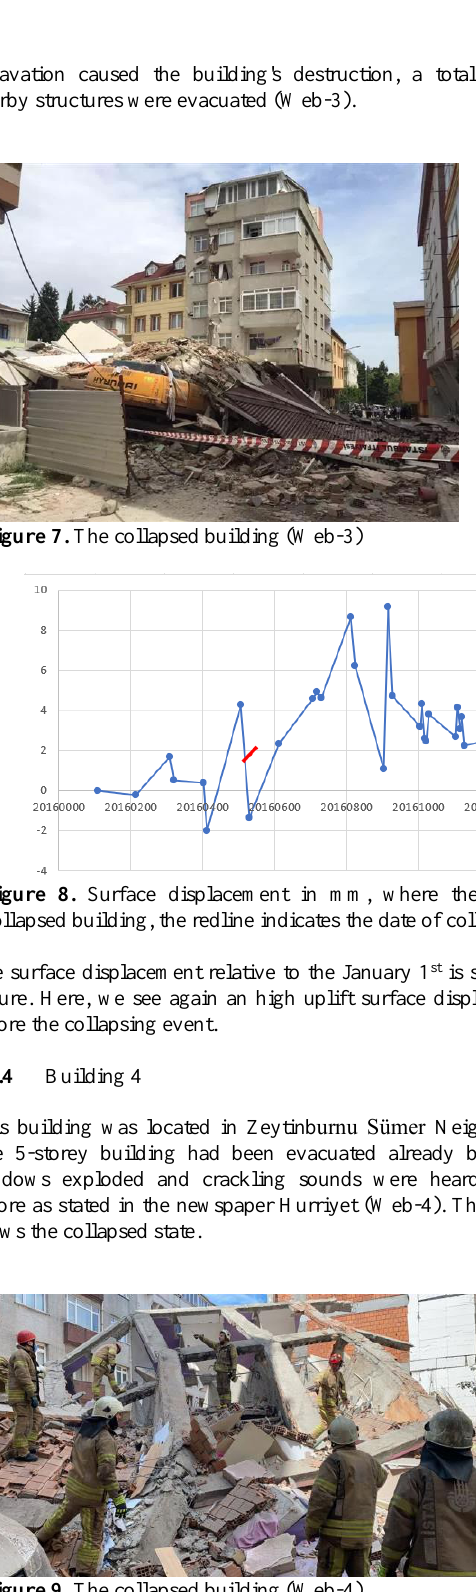
Figure 9. The collapsed building (Web-4) The graphic depicts an upward movement trend on the surface that reached a height of around 12 cm before the event collapsed.